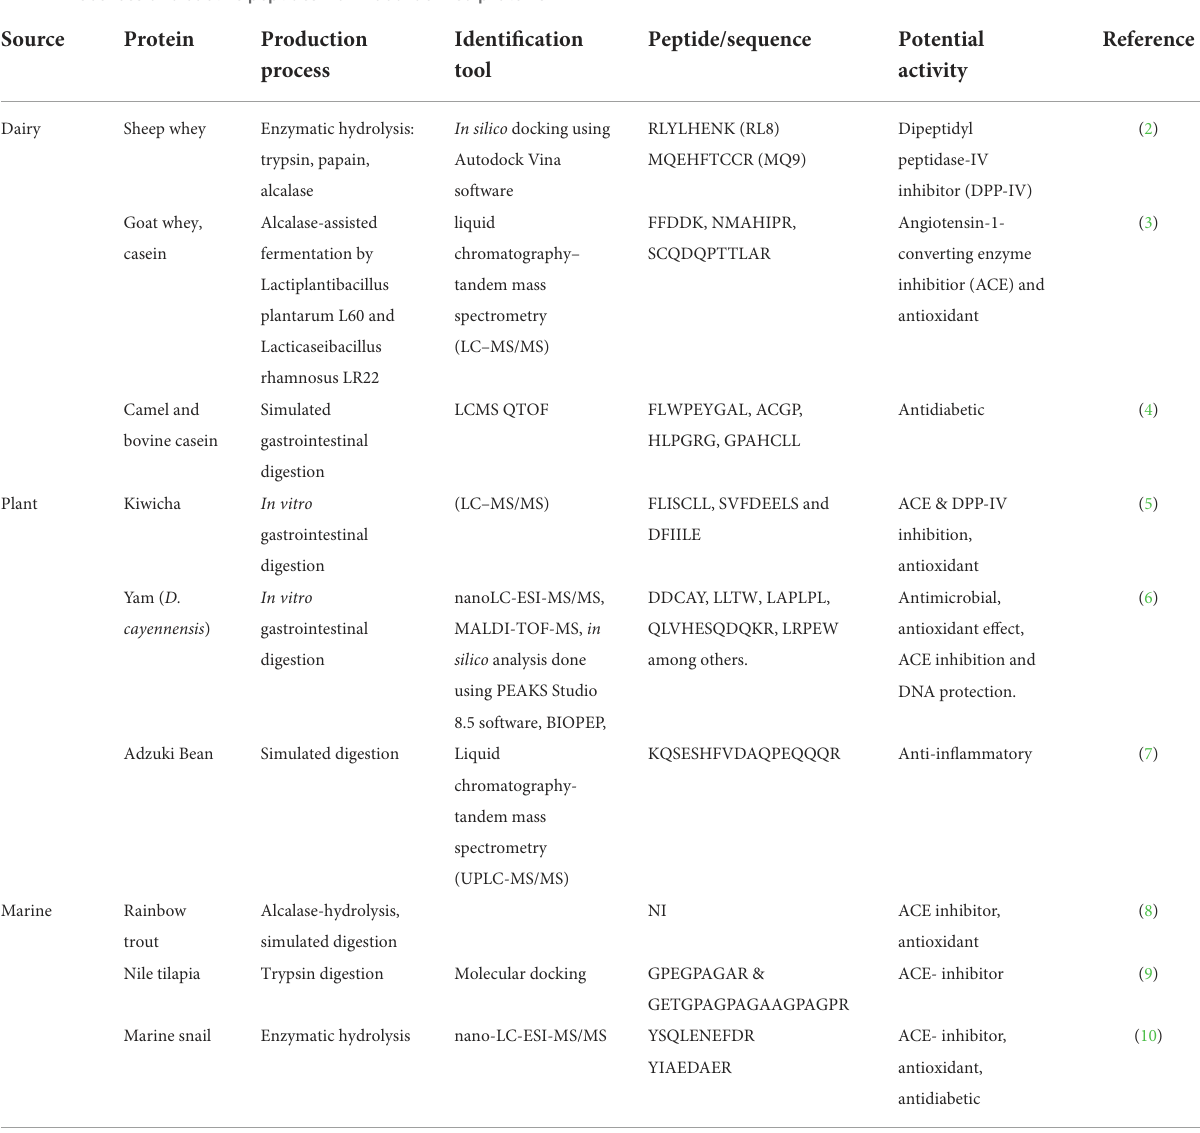
TABLE 1 Sources of bioactive peptides from food-derived